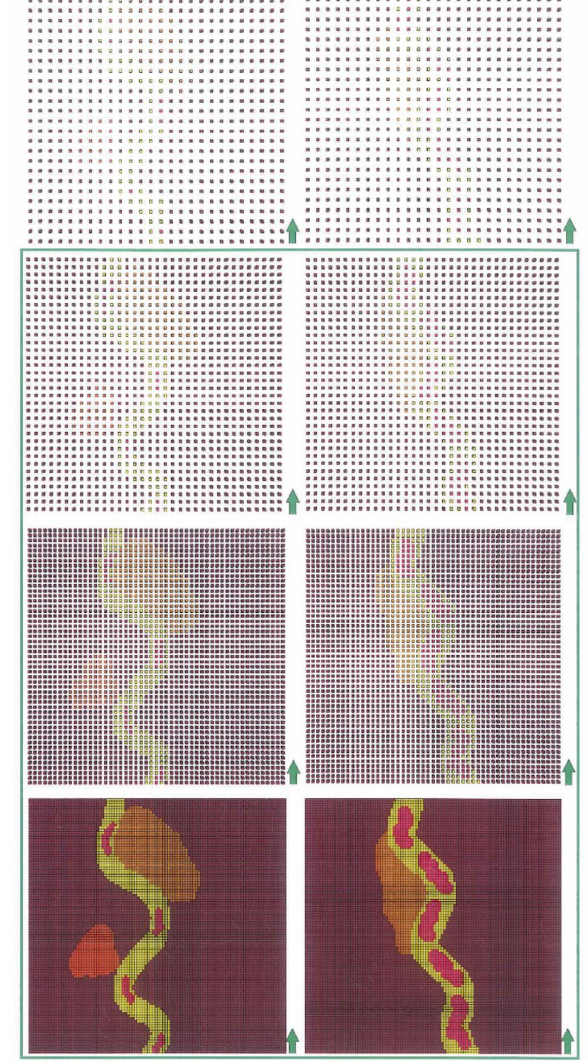
Fig. 17 Training image corresponds to 4, 3, 2, and 1